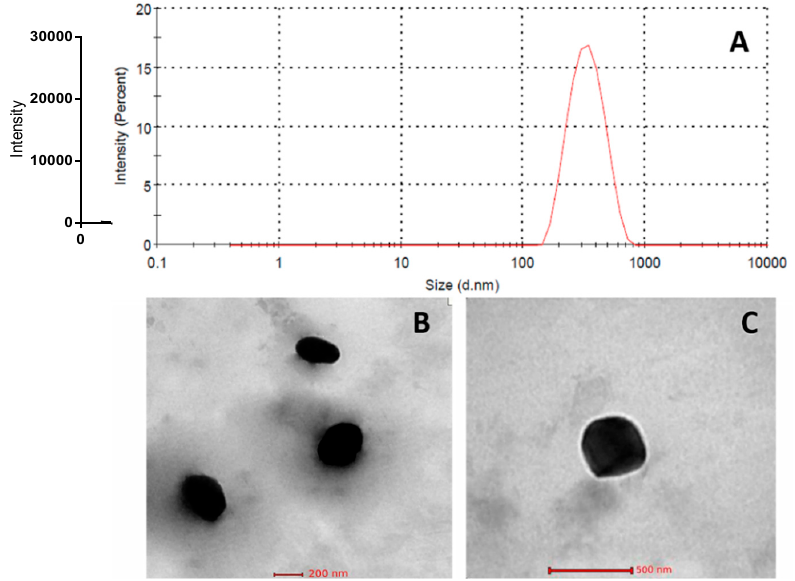
Figure 7. Representative intensity-weighted particle size distribution profile of temazepam NLC-1 suspension ( A ); and TEM micrographs (×52,000) ( B ) and (×150,000) ( C ).